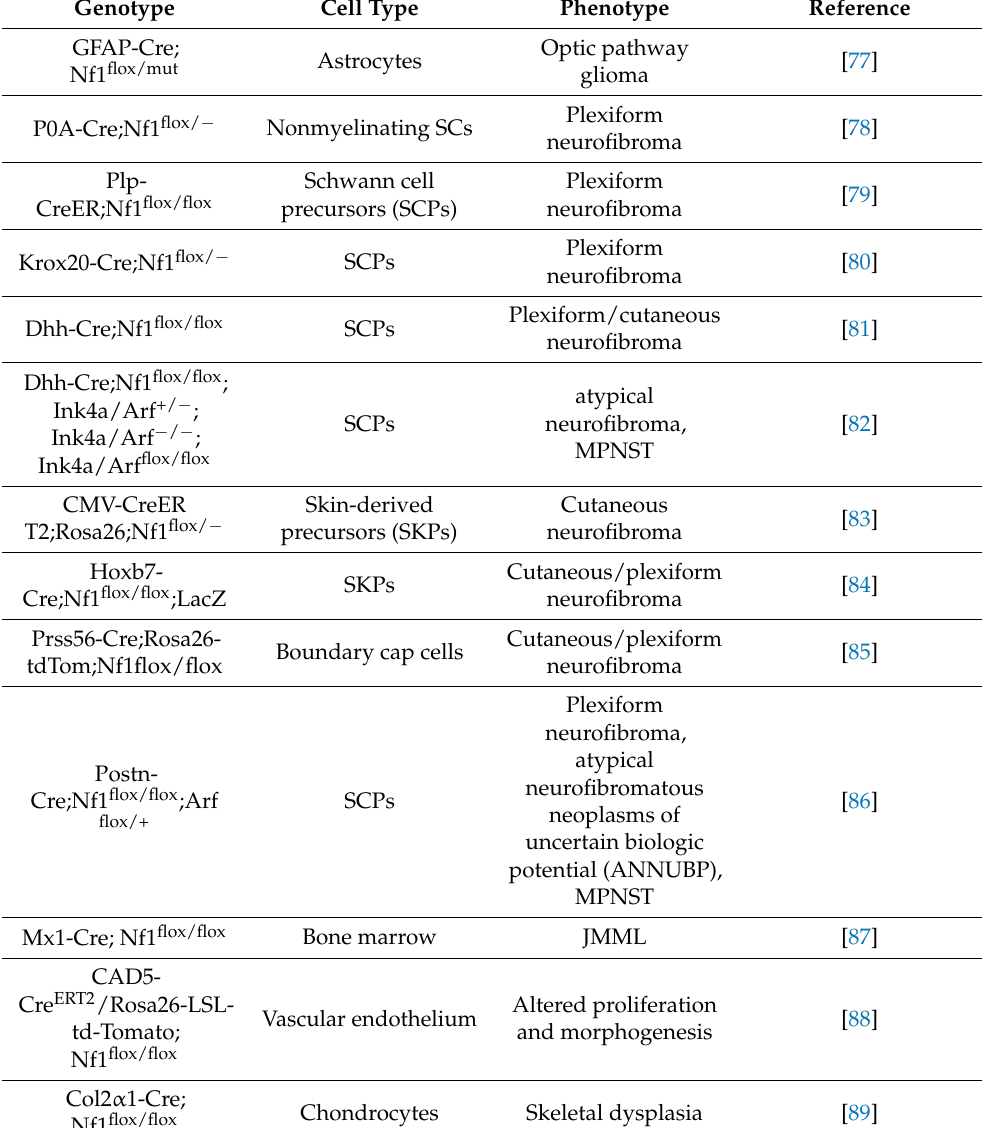
Table 1. GEMM of NF1-associated clinical manifestations using the Cre-Lox